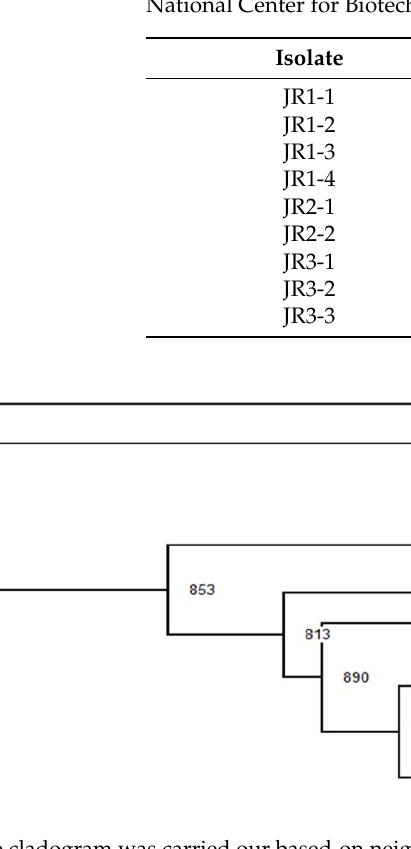
Figure 4. The cladogram was carried our based-on neighbour-joining technique illustrating the phylogenetic relationship among isolate JR1-1, JR1-2 and JR3-2 with other interconnected analogous bacterium based on 16S rRNA gene sequence examination. Bacillus cereus was the outgroup. Table 6. Identified isolates name based on phylogenetic analysis with registered accession number in National Center for Biotechnology Information